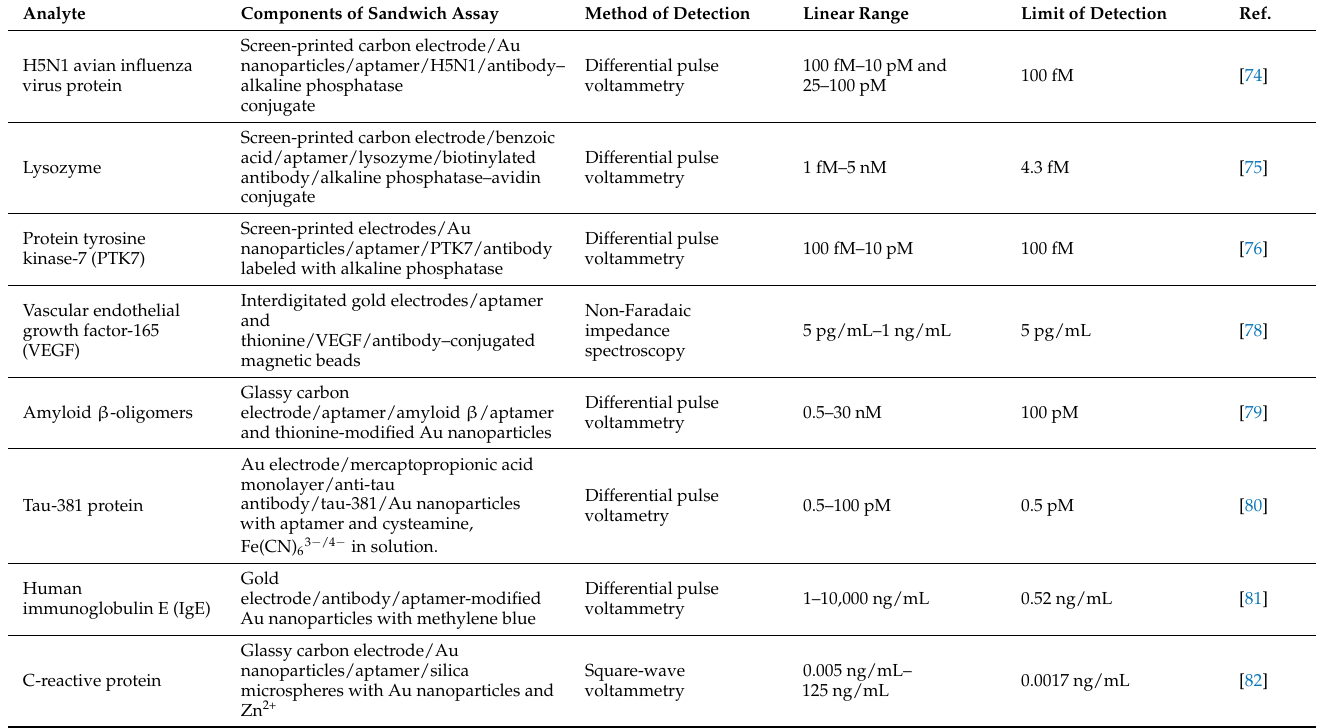
Table 3. Electrochemical Sandwich Assays Combining Aptamers and